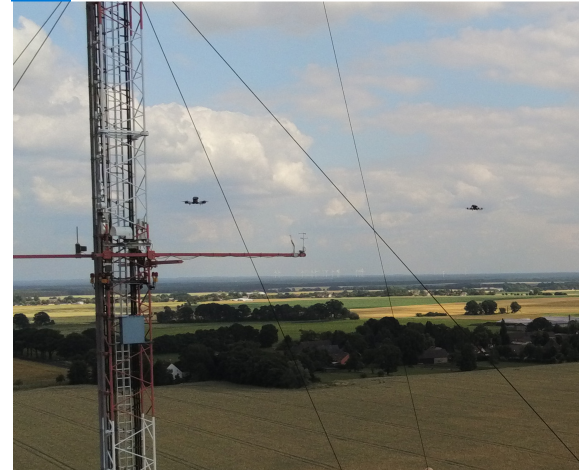
Figure 1. Two Holybro QAV250 UAS in flight. In the background the 99m mast with a sonic anemometer on the boom at 50m can be